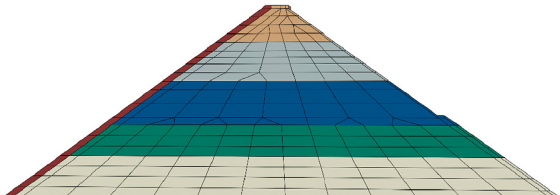
Figure 10: The finite element mesh of the maximum dam cross- section A-A.